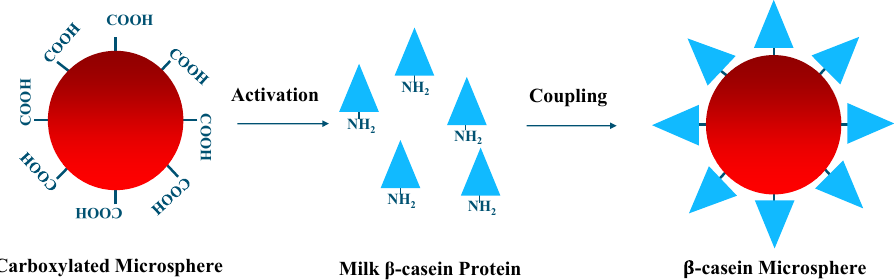
Figure 8. Graphical explanation of microsphere coupling procedure.